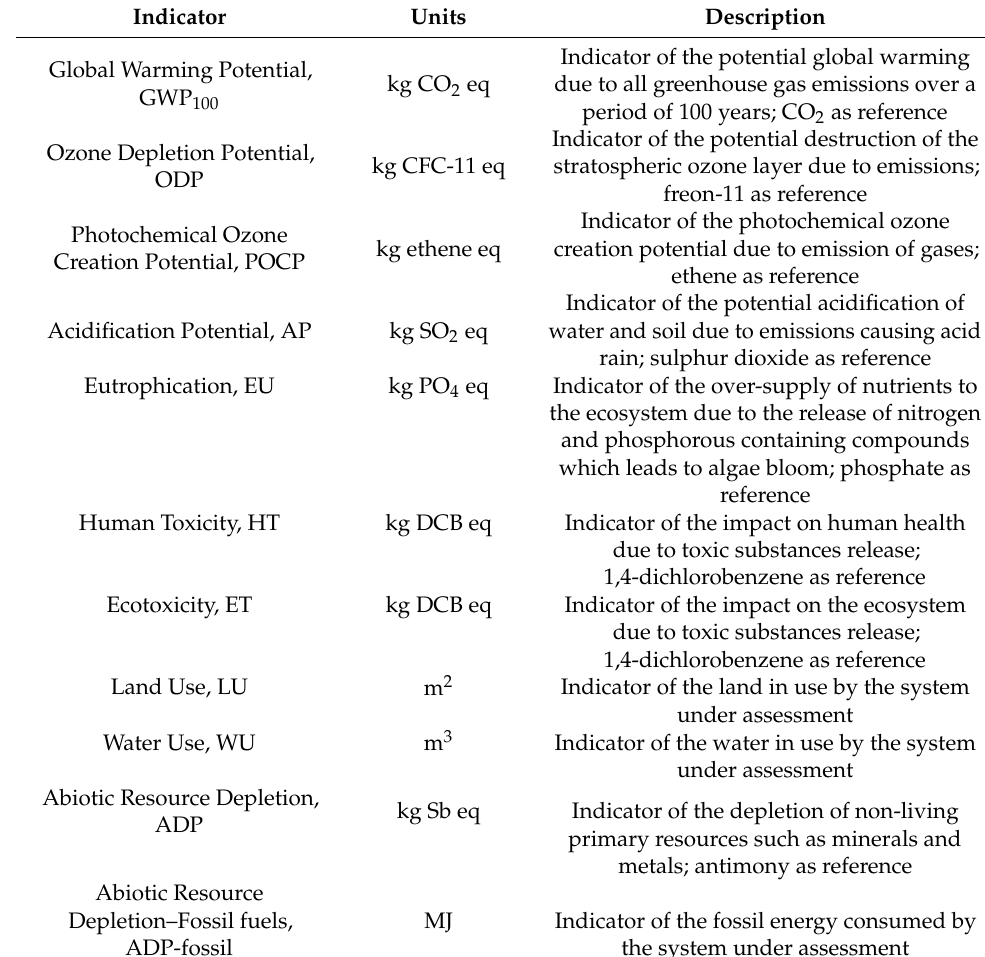
Table 5. Impact category indicators in use in life cycle